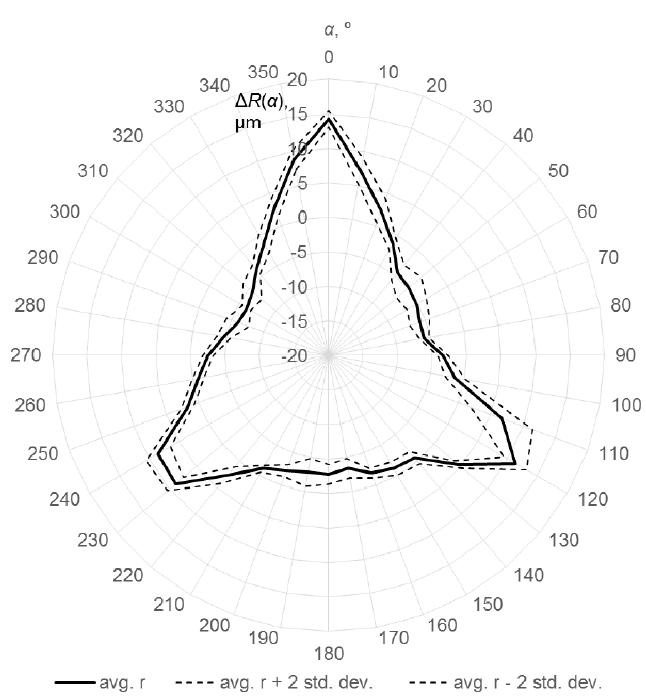
Figure 5. Results obtained on the machine tool for ultra-compact touch-trigger probe with 100 mm stylus, for measurement speed equal to 50 mm/min.